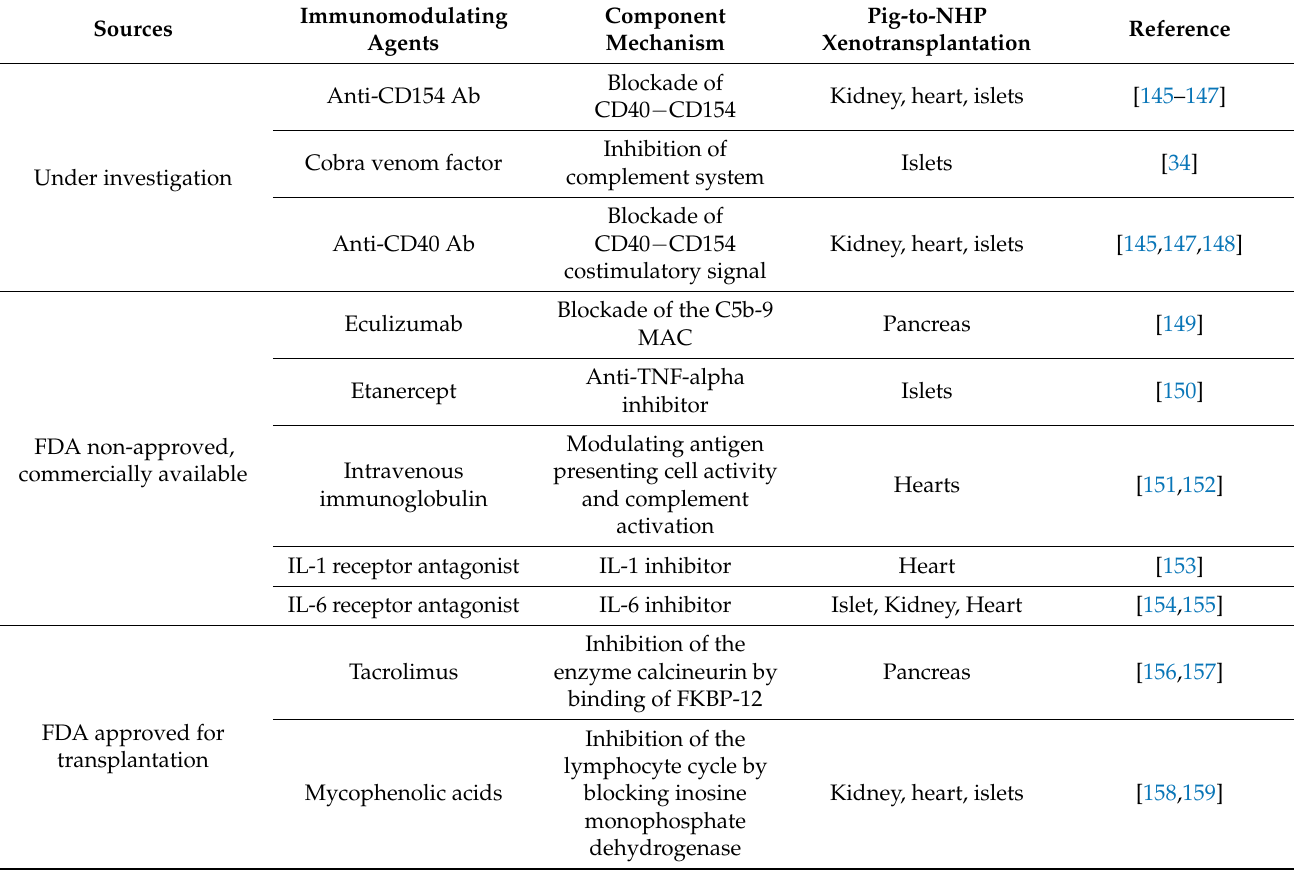
Table 2. Immunomodulating agents applied to